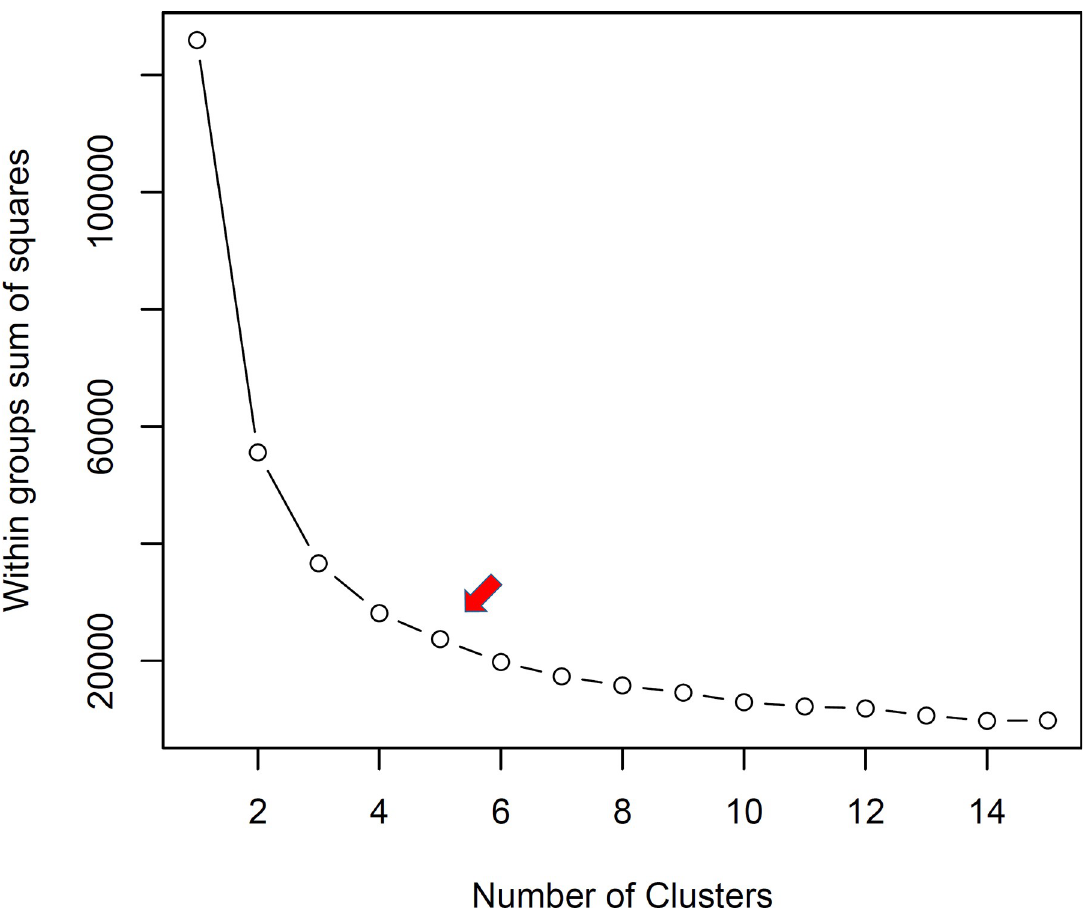
Fig 2. Within-group sum of squares of 228 biofortified cassava genotypes based on phenotypic data of total carotenoid content and colorimetric indices (CIELAB). The grouping criterion was based on the K-means clustering algorithm.